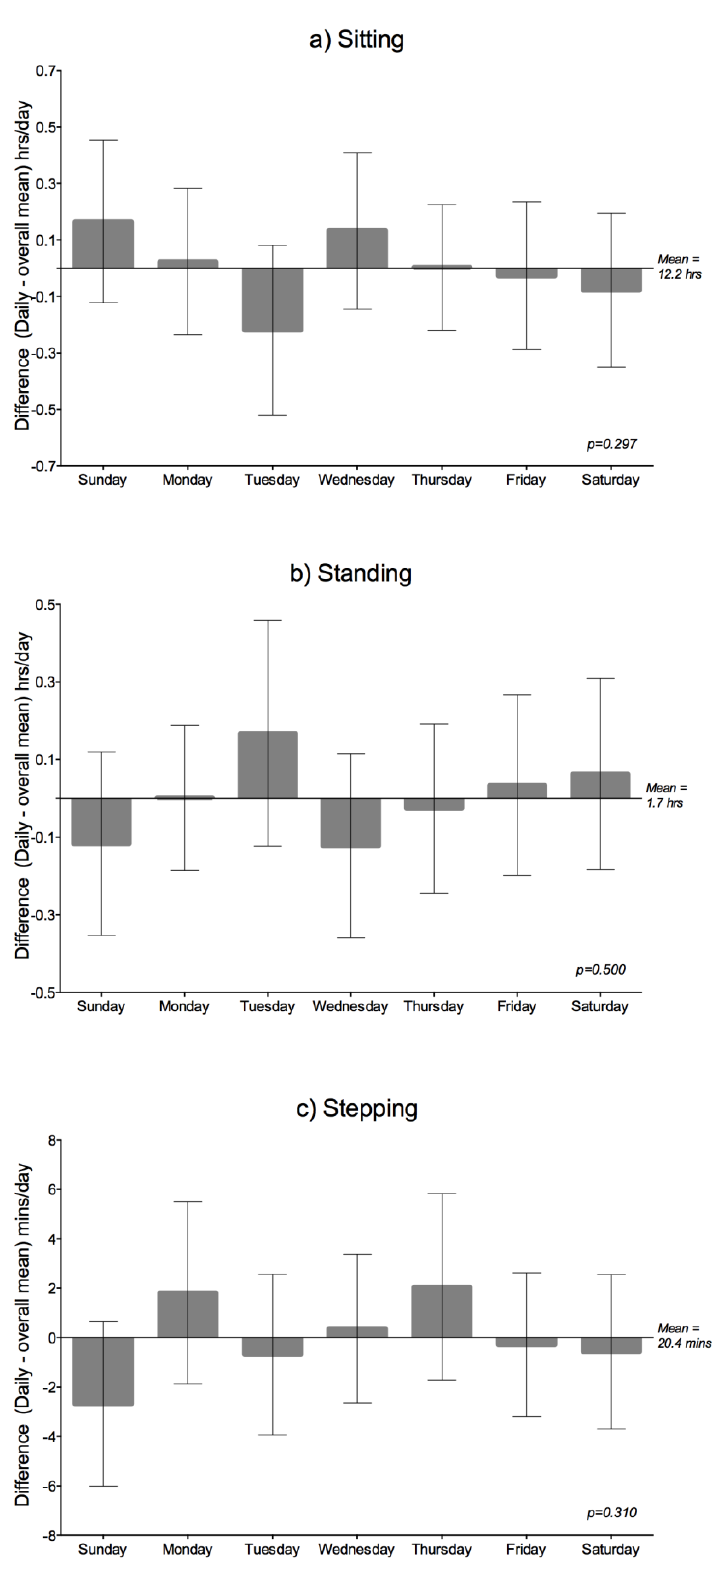
Figure 2. Average (mean, 95% CI) time spent ( a ) Sitting ( b ) Standing and ( c ) Stepping for 31 adults in residential aged care. Twenty-eight observations were available for Sunday, Monday, Tuesday, and Friday, while 29 were available for the remaining days. The sitting time and stepping time analyses included age, gender, cognitive impairment, depression, mobility and falls as covariates, whereas the walking time analysis included only cognitive